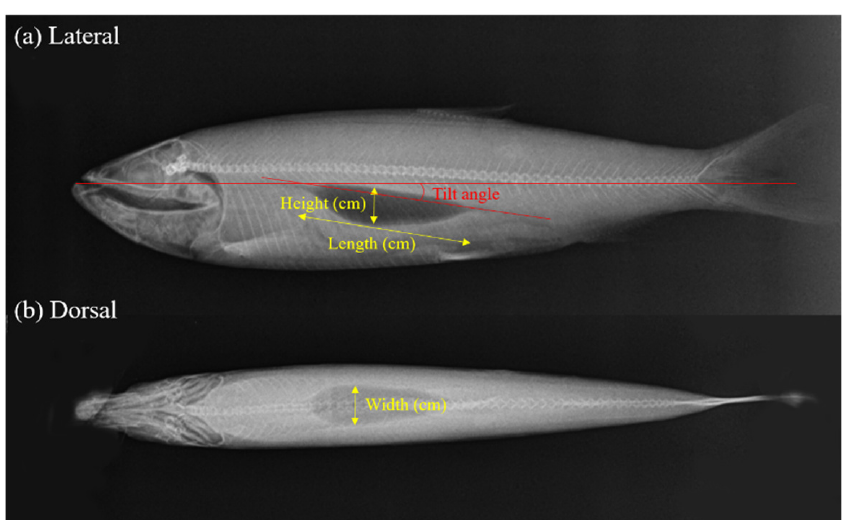
Figure 3. X-ray image of the ( a ) lateral and ( b ) dorsal aspects of Pacific herring. The swim bladder angle ( θ ) is indicated as the tilt angle of the swim bladder, centerline between anterior and posterior margins, according to the fish body. The swim bladder length is indicated by the distance between the swim bladder anterior and posterior margins. The swim bladder height is indicated as the maximum thickness of the swim bladder in the lateral aspect. The swim bladder width is indicated as the maximum thickness of the swim bladder in the dorsal aspect.